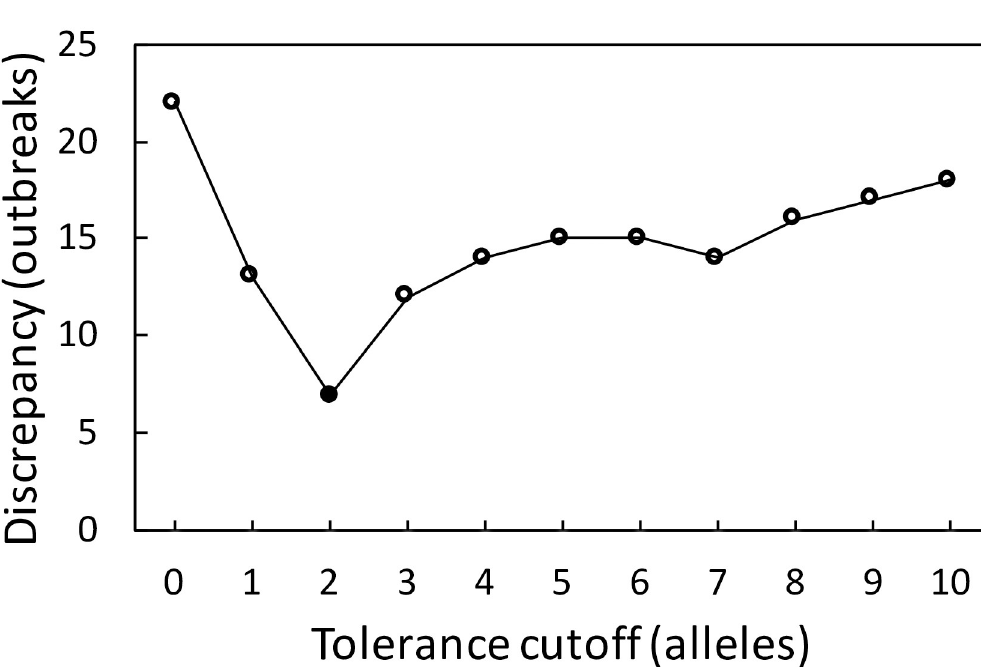
Fig 1. Discrepancy between CT types and LmScheme_370 types for the 35 outbreaks of Set B when the tolerance cutoff is varied from 0 to 10. The total numbers of different type counts in the 35 outbreaks of Set B between the CT types and groups counts based on the LmScheme_370 single-linkage clustering for each outbreak were calculated.